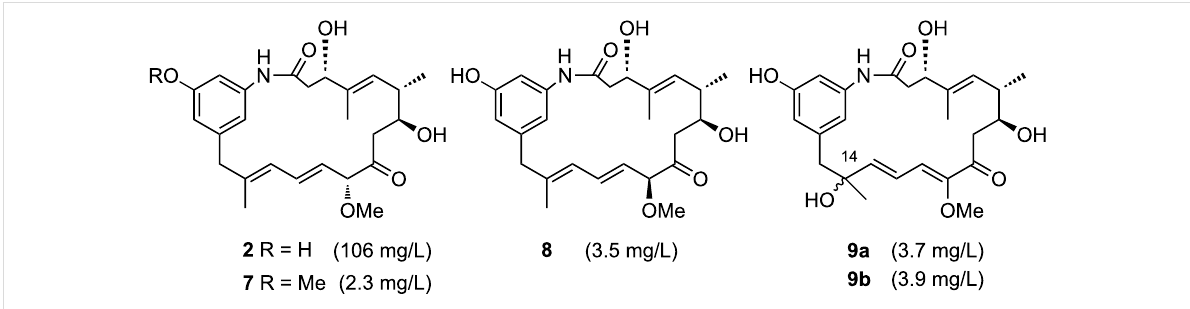
Figure 1: Fermentation products, proansamitocin ( 2 ) and derivatives 7 – 9 , of the Asm12 and Asm21-blocked (chlorination, carbamoylation) mutant strain A. pretiosum Δ asm12/21 (yields given as isolated product per volume of fermentation broth) [17].